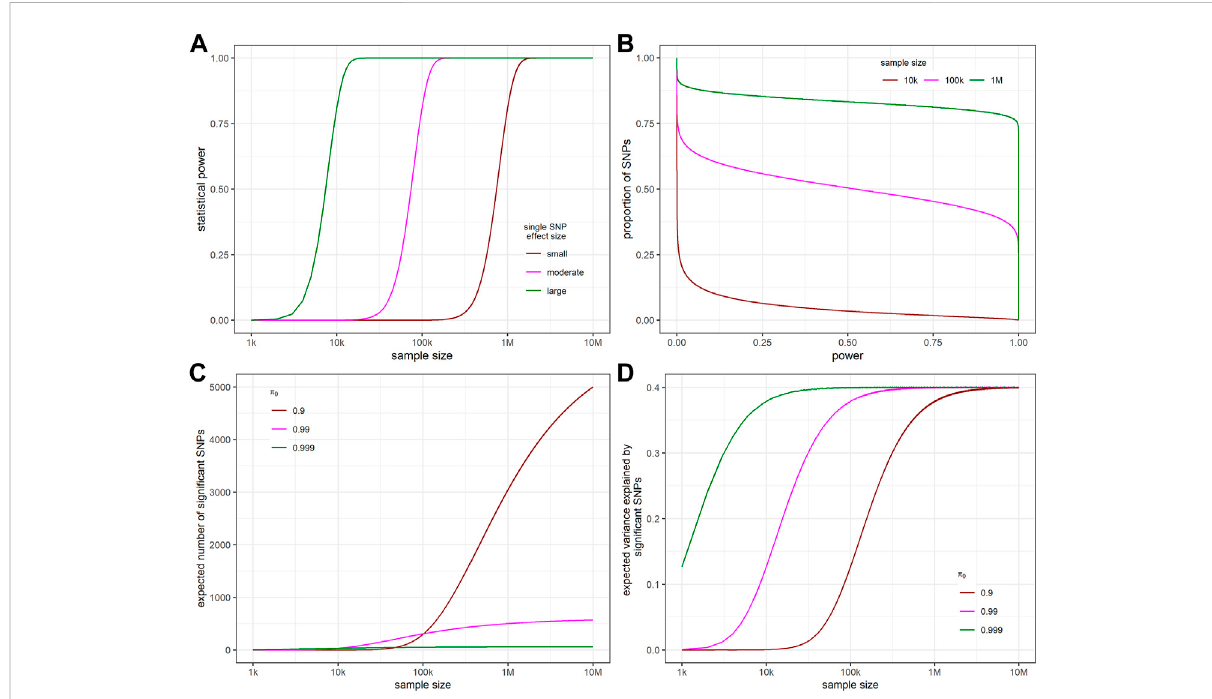
FIGURE 2 The relationship between statistical power, sample size, expected number of signi fi cant SNPs, and apparent variance explained by signi fi cant SNPs. (A) The relationship between sample size and the statistical power to detect a single SNP with different effect sizes “ small ” , “ moderate ” , and “ large ” representing SNPs that explain0.01%, 0.1%,and 1%of SNP heritability. (B) ProportionofSNPs with atleast that level ofstatistical power onthe x-axis for different samplesizes. (C) Relationship between expected number ofsigni fi cantSNPs and sample sizes. (D) Relationship between the expected variance explained by the signi fi cant SNPs and sample sizes. For all fi gures, h 2 = 0.4, m = 60,000, α = 5 × 10 − 8 . For B, π 0 =